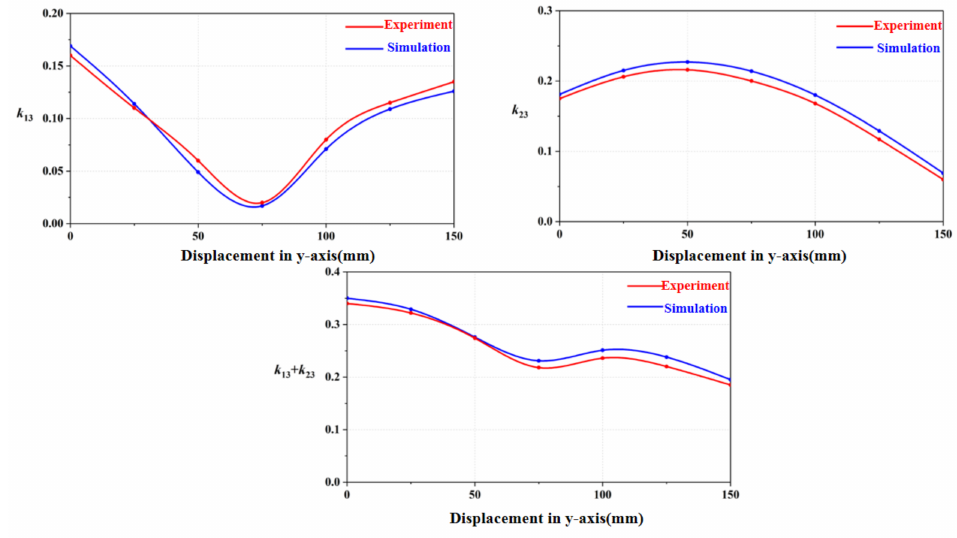
Figure 12. Variation of the coupling coefficient with displacement.